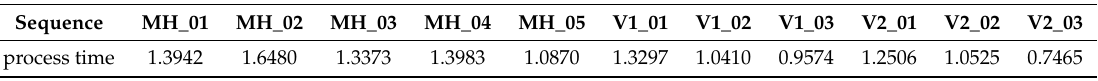
Table 2. Mean of the processing time (ms) of the proposed ORB descriptor-assisted outlier elimination procedure for every image.